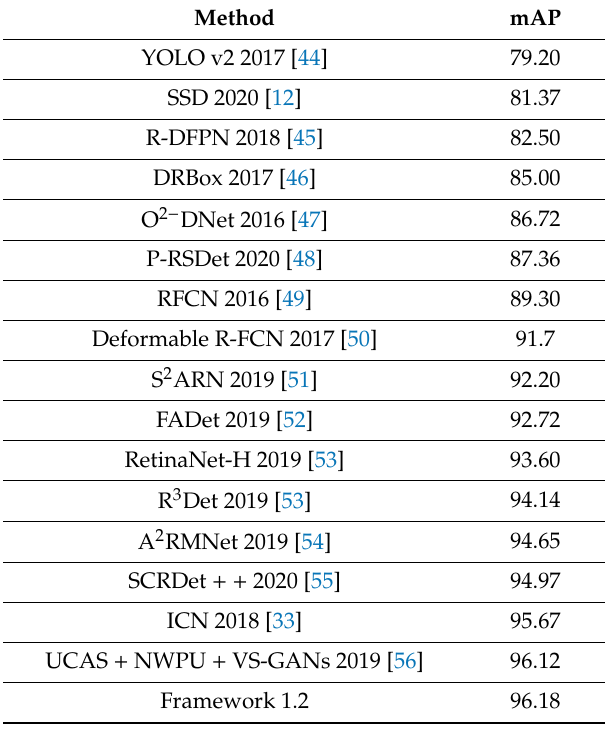
Table 3. Comparison between proposed framework and other methods on UCAS-AOD.